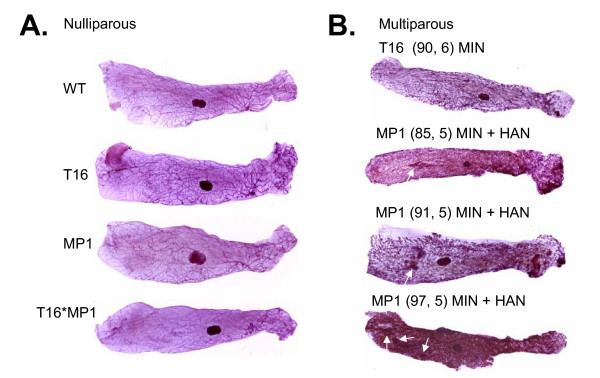
Normal mammary epithelium in cortactin and cyclin D1 nulliparous, but not in multiparous transgenic mice. (A) Whole mounts of the abdominal mammary gland from nulliparous mice of wild type (WT), cortactin transgenic (T16), cyclin D1 transgenic (MP1) and cortactin/cyclin D1 bitransgenic (T16*MP1) mice at 20 weeks of age. The dark spot in the middle represents a lymph node. (B) Whole mounts of the abdominal mammary gland of post-weaned multiparous mice with mammary intraepithelial neoplasia (MIN) and hyperplastic alveolar nodules (HAN, arrows). The age in weeks and the number of pregnancies that the mouse went through, are indicated between brackets.